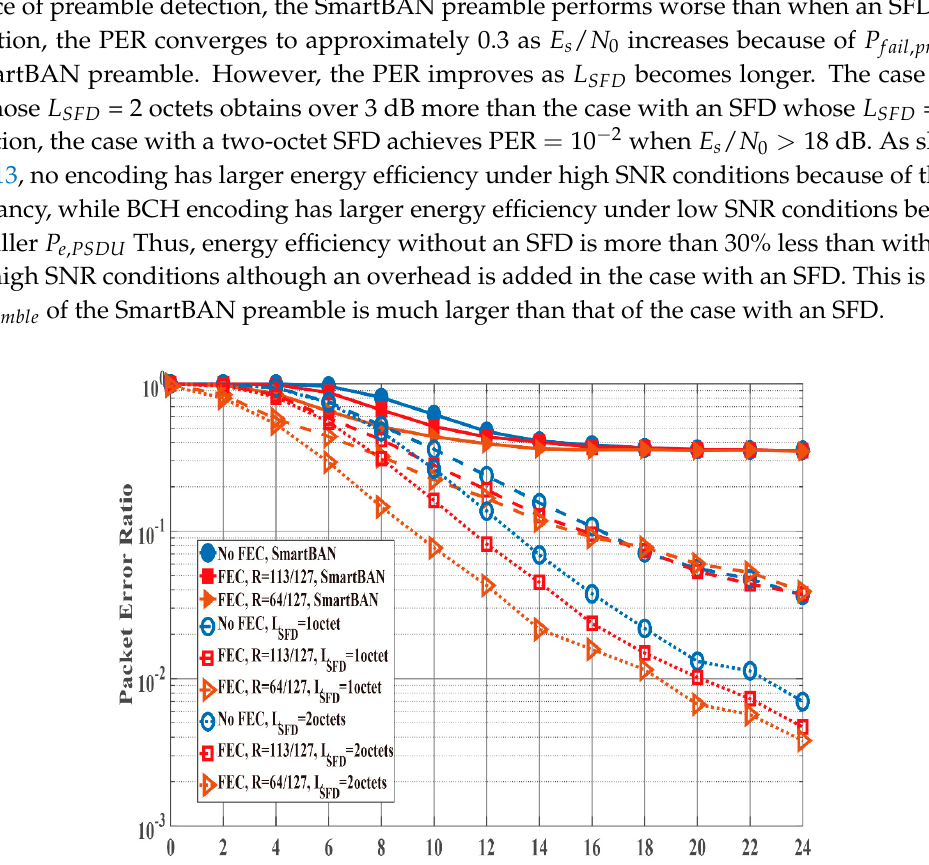
Figure 11. Computational complexity for preamble detection.